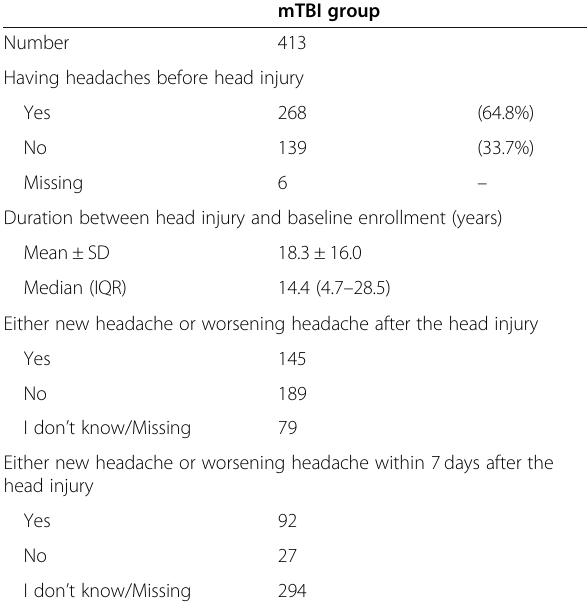
Table 2 Time course of head injury and its characteristics among TBI group